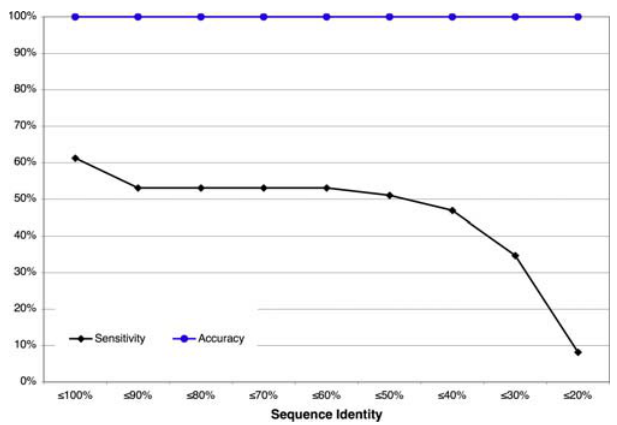
Figure 4. ETA and Sequence Identity. ETA performance on the PSI Test Set is shown, removing matches above a sequence identity cutoff to explore the importance of matches with varying levels of similarity. Sensitivity (black diamonds) is the percentage of the 49 proteins for which ETA predicts a correct function; accuracy (blue circles) is the percentage of these predictions that are correct.